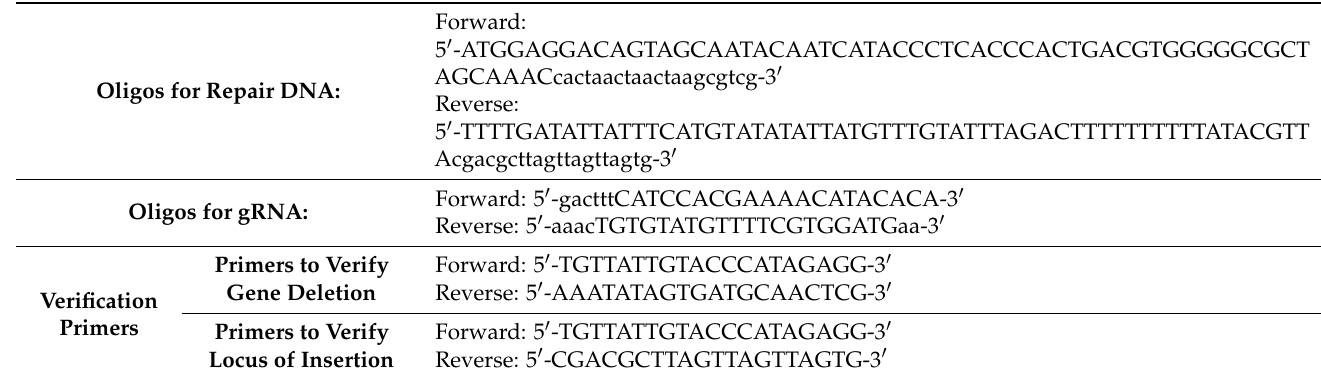
Table 2. Oligonucleotide sequences of repair DNA, gRNA, and verification primers. The insertion cassette is indicated with lowercase letters within the repair DNA sequences. gRNA modifications according to Akhmetov et al. [65] are also indicated with lowercase